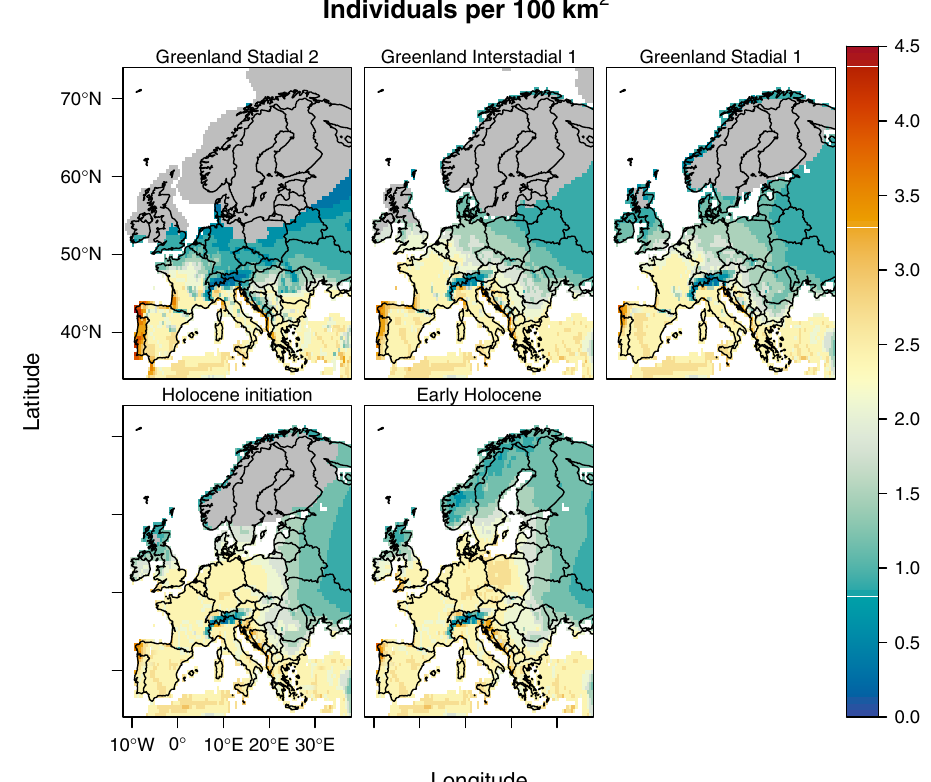
Fig. 4 | Estimated human population density (persons/100km 2 ) across Europe for selected times during the 21ky to 8kyBP period. Predictions are based on 50th percentile generalised additive models (qGAM), and any human presence is